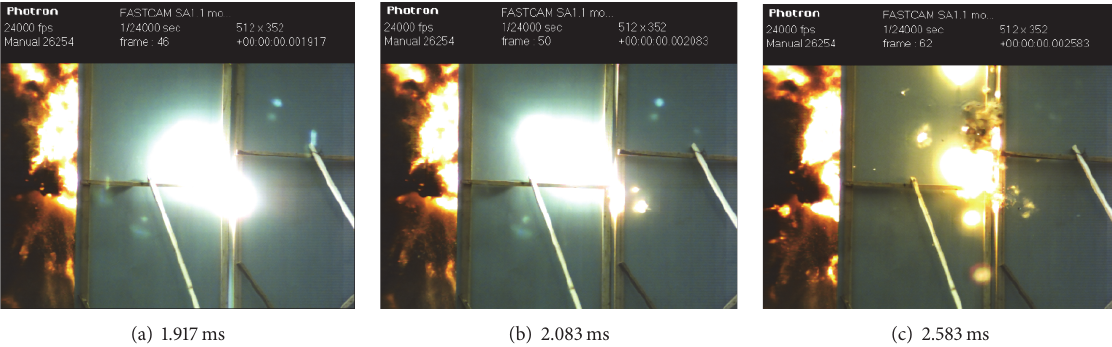
Figure 5: The high speed photography record of the concave-120 ∘ experiment.